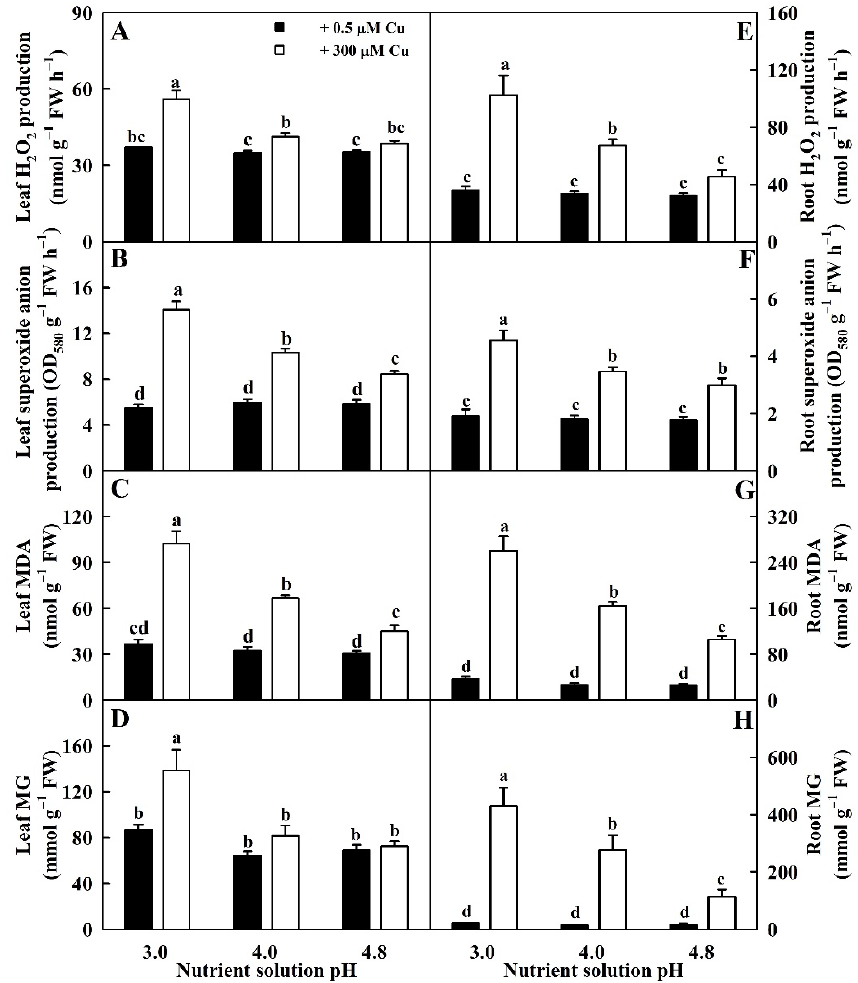
Figure 1. Impacts of Cu–pH interactions on HPR ( A , E ), SAPR ( B , F ), MDA ( C , G ), and MG ( D , H ) concentrations in leaves and roots. Bars represent means ± SE ( n = 4). Different letters above the bars indicate a significant difference at p < 0.05.